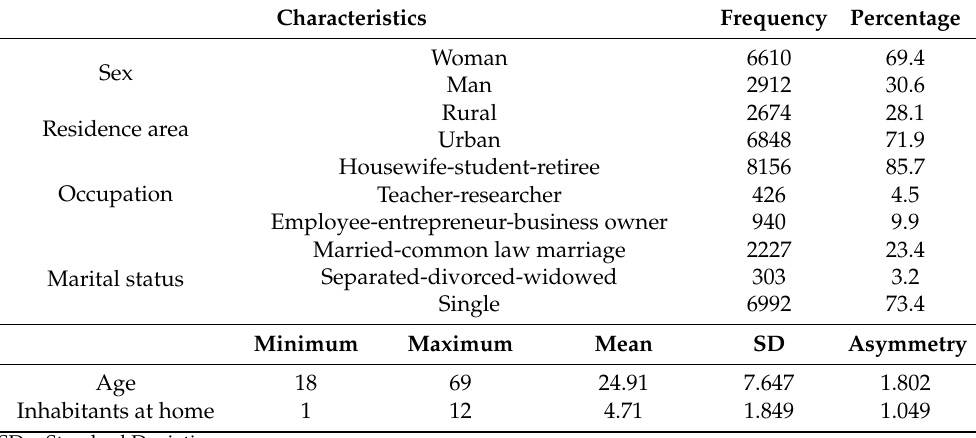
Table 1. Demographic characteristics studied. Adult population, both sexes.